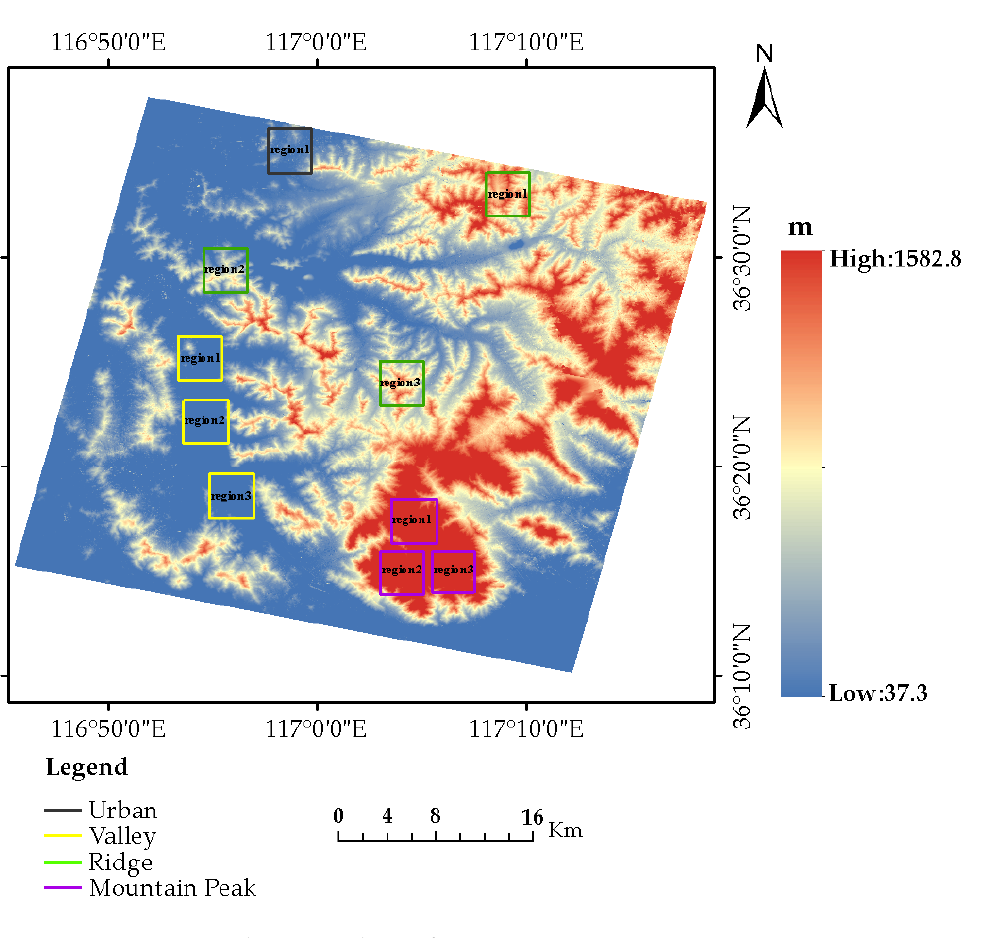
Figure 5. The extracted DSM from GF-6 WFV HR images. The spatial resolution of the extracted DSM is 10 m, and the elevation ranges from 37.3 m to 1582.8 m. From an overall optical view, the DSM extracted from GF-6 panchro- matic images can recover the surface morphology of the proposed method. 3.3. DSM Accuracy Analysis The test area included four different geographical types, namely valleys, ridges, peaks, and flat urban areas. In order to verify the elevation accuracy of the DSM extracted from GF-6 satellite images in different terrains, we conducted a local elevation profile analysis and pixel-by-pixel accuracy analysis on different regions of the various terrains. For peak topography, the three main peaks of Mount Tai with the largest topographic reliefs were selected. For ridge topography, three areas with the most uniform distribution in the whole experiment area were selected. For valley topography, three areas were also selected in the concentrated valley area. Due to the small cover of urban areas, only one area was selected. The selected valleys, ridges, peaks, and flat urban areas are marked by